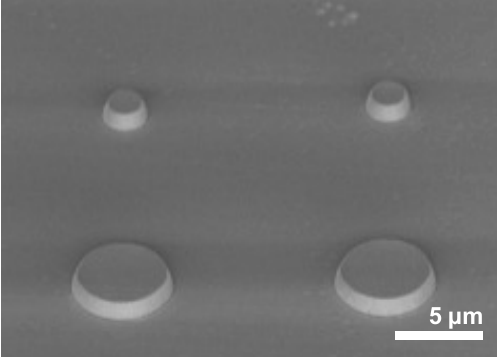
Figure 1. Scanning electron microscopy (SEM) micrograph of one of the substrates after inductively coupled plasma reactive ion etching (ICP-RIE) process.